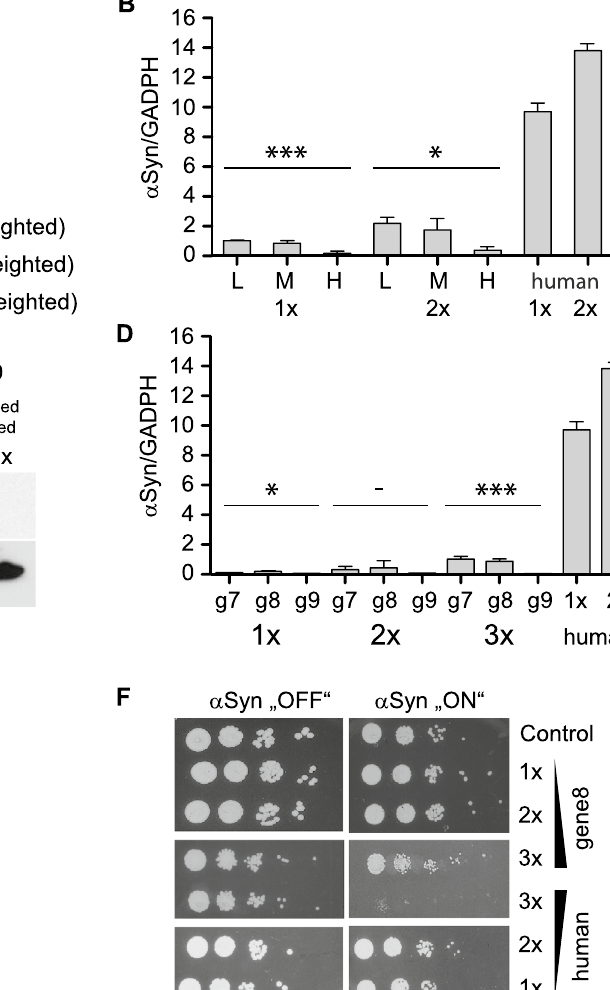
in addition to the gene sequence. As discussed above, most software to design entire gene sequences optimize the CAI. However, the used codon usage tables most often do not refer to the codon usage of only the highly